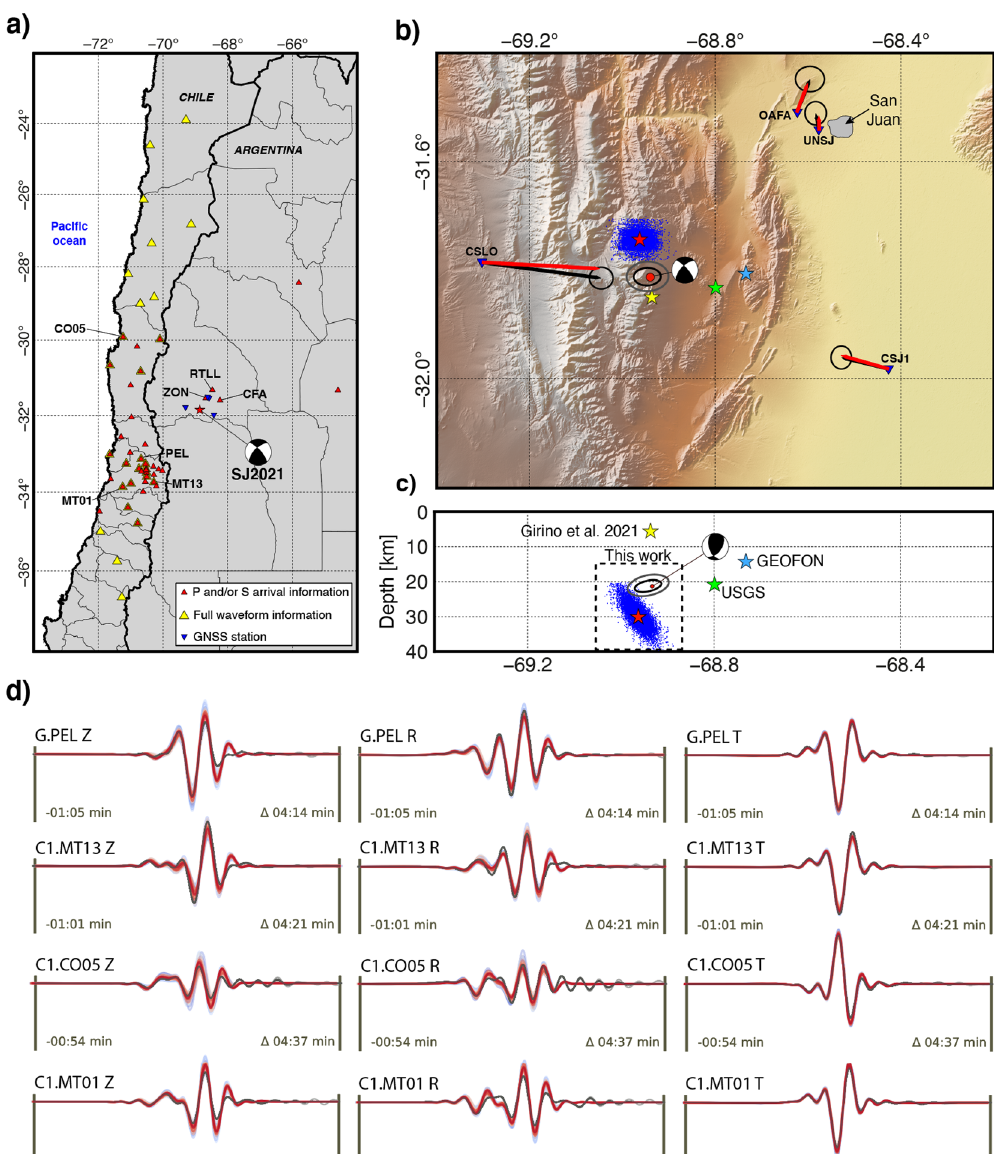
Figure 2. Refined source parameters of the 2021 San Juan earthquake. ( a ) Map showing the location of seismic and GNSS stations used in this study. Red triangles denote seismic stations used for earthquake relocation. Yellow triangles indicate stations for which the full waveform was used in inversion of the full moment tensor. Blue inverted triangles represent the GNSS stations used in this study. ( b ) Map showing epicentral locations for the 2021 San Juan earthquake (SJ2021) corresponding to the USGS 15 solution (green star), GEOFON solution (blue star), Girino et al. 33 (yellow star), our relocated epicenter (red star, with samples of the hypocenter probability density function shown as blue dots), and our final location and focal mechanism solution from the inversion of regional waveforms and GNSS coseismic displacement (beachball diagram and red dot). ( c ) Cross section view of the information presented in ( b ) projected onto section line A–B. Note that the SJ2021 focal mechanism solution has been rotated into the cross section plane. ( d ) Seismic waveforms corresponding to 4 example stations (see Fig. 2a for location) with observed surface waves (gray) after restitution, filtering, tapering and rotation into ZRT coordinate system, and corresponding synthetic waveforms ensemble (colored from blue to red with decreasing misfit). ( a )–( c ) were generated using the GMT package (V6.0.0, https:// www. gener ic- mappi ng- tools. org/) The topographic information in ( c ) corresponds to the Shuttle Radar Topographic